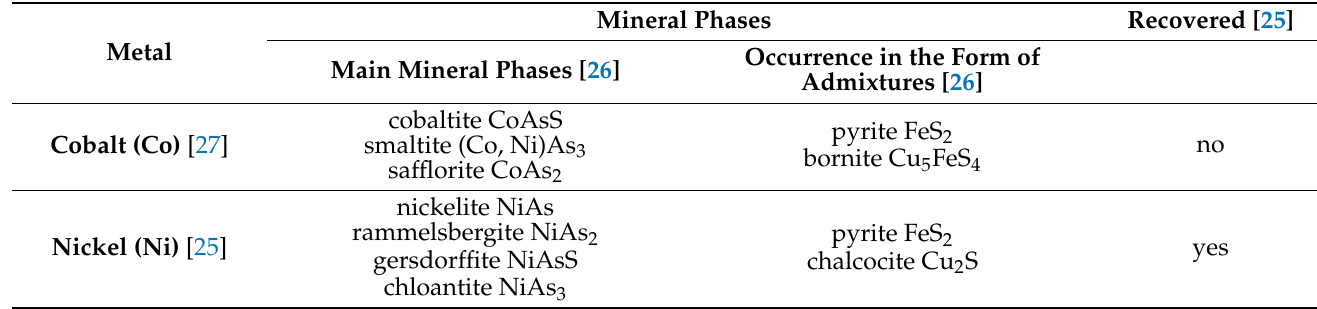
Figure 3. An example of determining the deposit boundary in the vertical profile including three main lithological types of ores: carbonate ore, the Kupferschiefer ore, and sandstone ore with information on the Cu content in point samples. Table 1. Metal bearing mineral phases in the Cu-Ag deposits (the